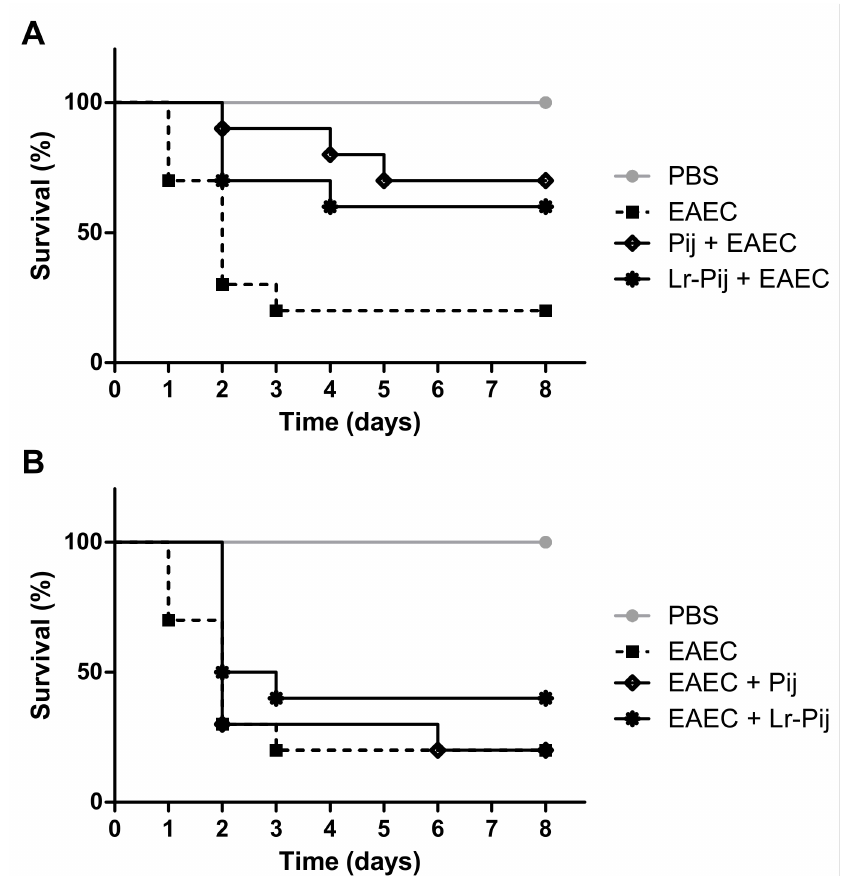
Figure 4. Effects of fermented and non-fermented juices on the infection induced by enteroaggrega- tive Escherichia coli 042 in larvae of Tenebrio molitor . ( A ) Anti-infective effects of the pre-treatment with fermented and non-fermented juices on the infection induced by E. coli . ( B ) Anti-infective effects of the treatment with fermented and non-fermented juices on the infection induced by E. coli . PBS: phosphate-saline buffer; EAEC: enteroaggregative Escherichia coli 042; Pij: unfermented Platonia insignis juice; Lr-Pij: Platonia insignis juice fermented by L. rhamnosus